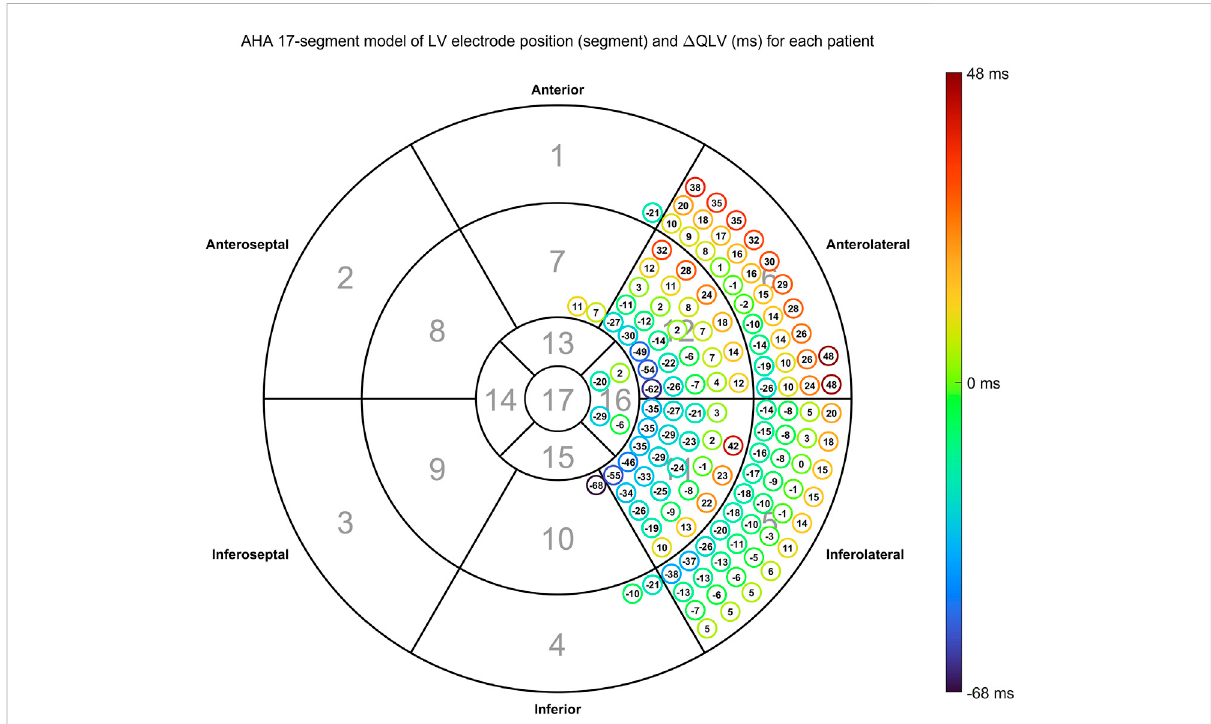
FIGURE 5 Time difference between estimated and measured QLV ( Δ QLV )according to anatomical LV lead position. The encircled numbers show Δ QLV for each patient. The color of the circle is a visual representation of the Δ QLV value.